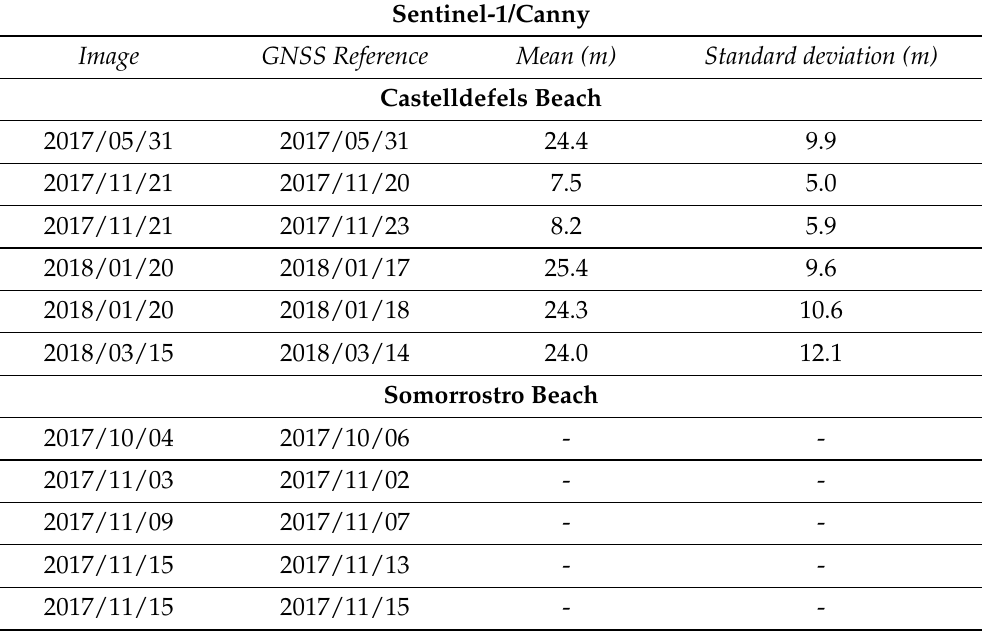
Table 6. Mean and standard deviation of the distances between Sentinel-1 shorelines and GNSS reference points in Castelldefels and in Somorrostro beaches by using the commonly used Canny Edge Detection